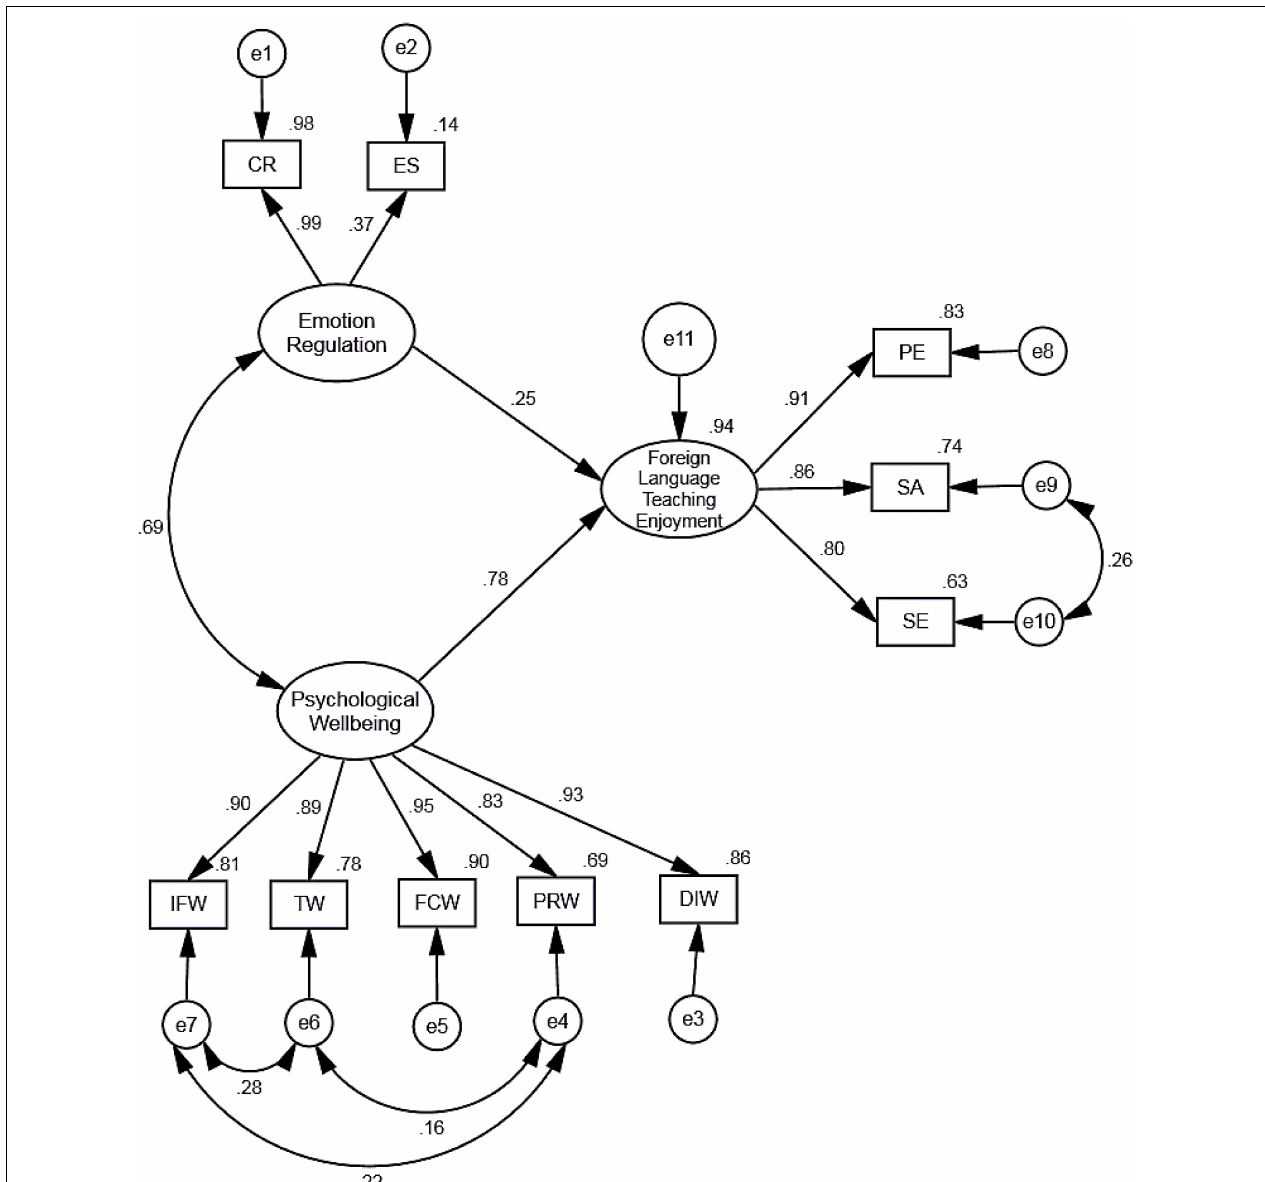
FIGURE 1 | The SEM model of the association between EFL teachers’ FLTE, psychological wellbeing, and emotion regulation. CR, Cognitive Reappraisal; ES, Expressive Suppression; IFW, Interpersonal Fit at Work; TW, Thriving at Work; FCW, Feeling of Competency at Work; PRW, Perceived Recognition at Work; DIW, Desire for Involvement at Work; PE, Personal Enjoyment of FL Teaching; SA, Student Appreciation in the FL Classroom; SE, Social Enjoyment of FL